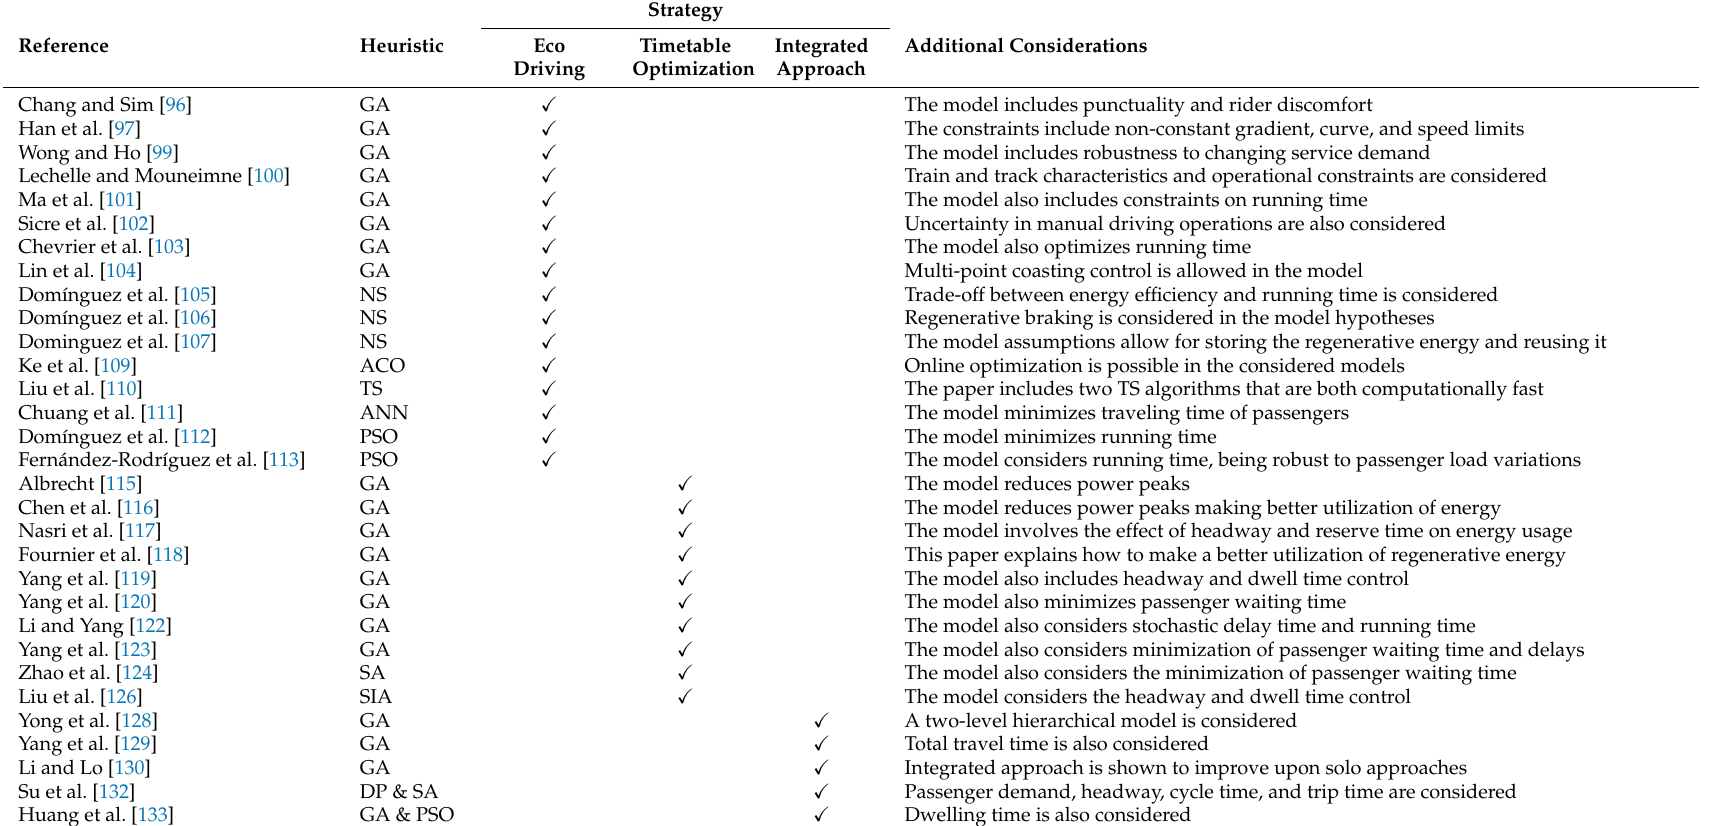
Table 5. Relevant literature in energy-related railway transportation optimization based on the employed heuristic method (GA, Genetic Algorithm; NS, Numerical Simulation; ACO, Ant Colony Optimization; TS, Tabu Search; ANN, Artificial Neural Networks; PSO, Particle Swarm Optimization; SA, Simulated Annealing; SIA, Swarm Intelligence Algorithm; DP, Dynamic Programming) and strategy